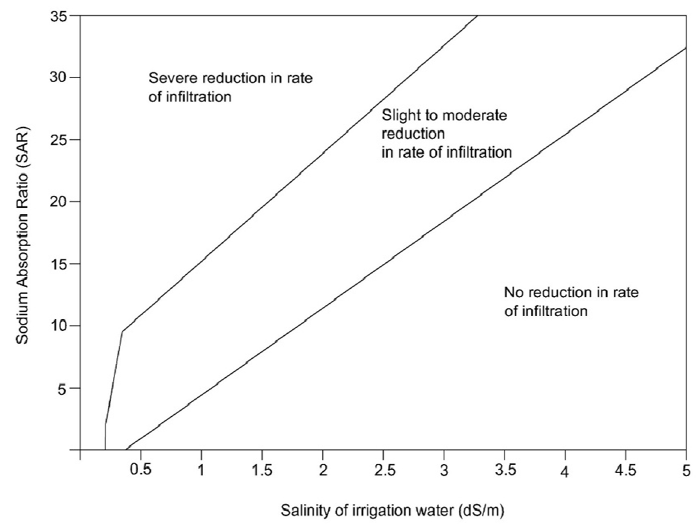
Figure 2. Reduction in soil infiltration rate as a ff ected by the Sodium Absorption Ratio and salinity of irrigation water.